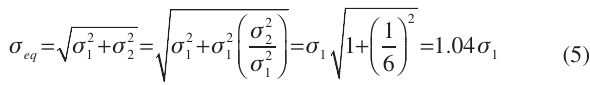
Table 2 and Figure 22 present the results for the tensile loading ratio σ